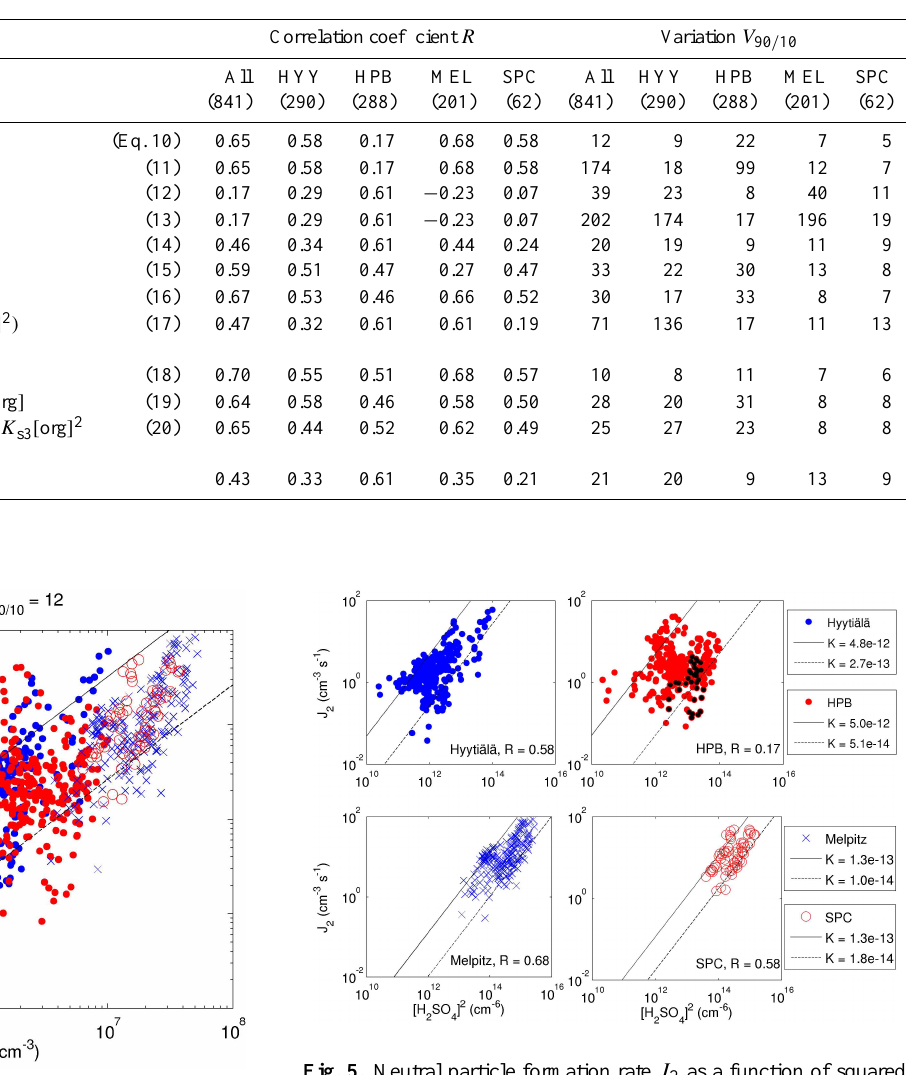
Table 2. Correlation coefficients R and variations V 90 / 10 achieved with all the tested nucleation mechanism models. The nucleation coefficient values for Eqs. (18) to (20) corresponding to the tabulated values of R and V 90 / 10 are presented in Table 3.